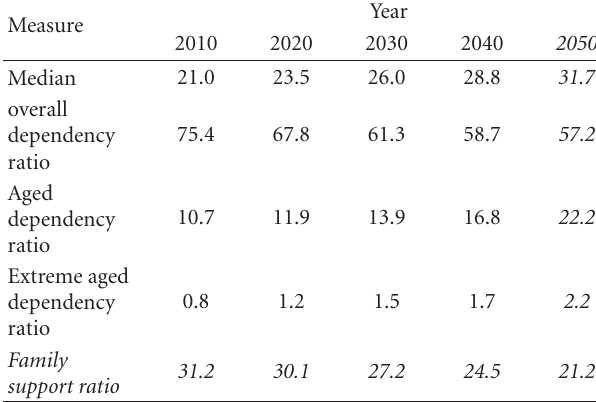
Source: computed from Table 5. Note. The median is expressed in years while the ratios are expressed in